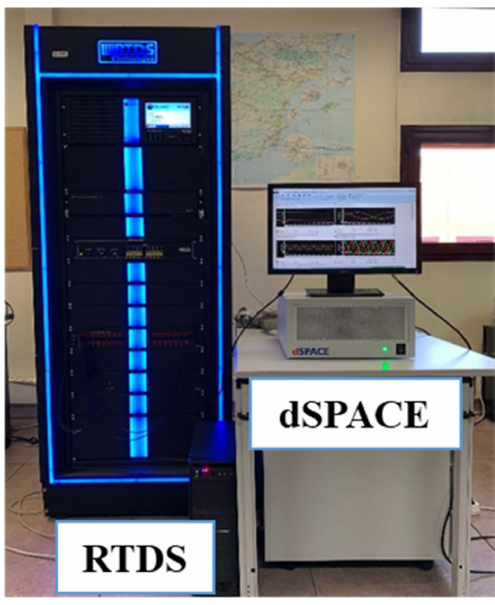
Figure 14. Hardware in the loop experimental set-up.